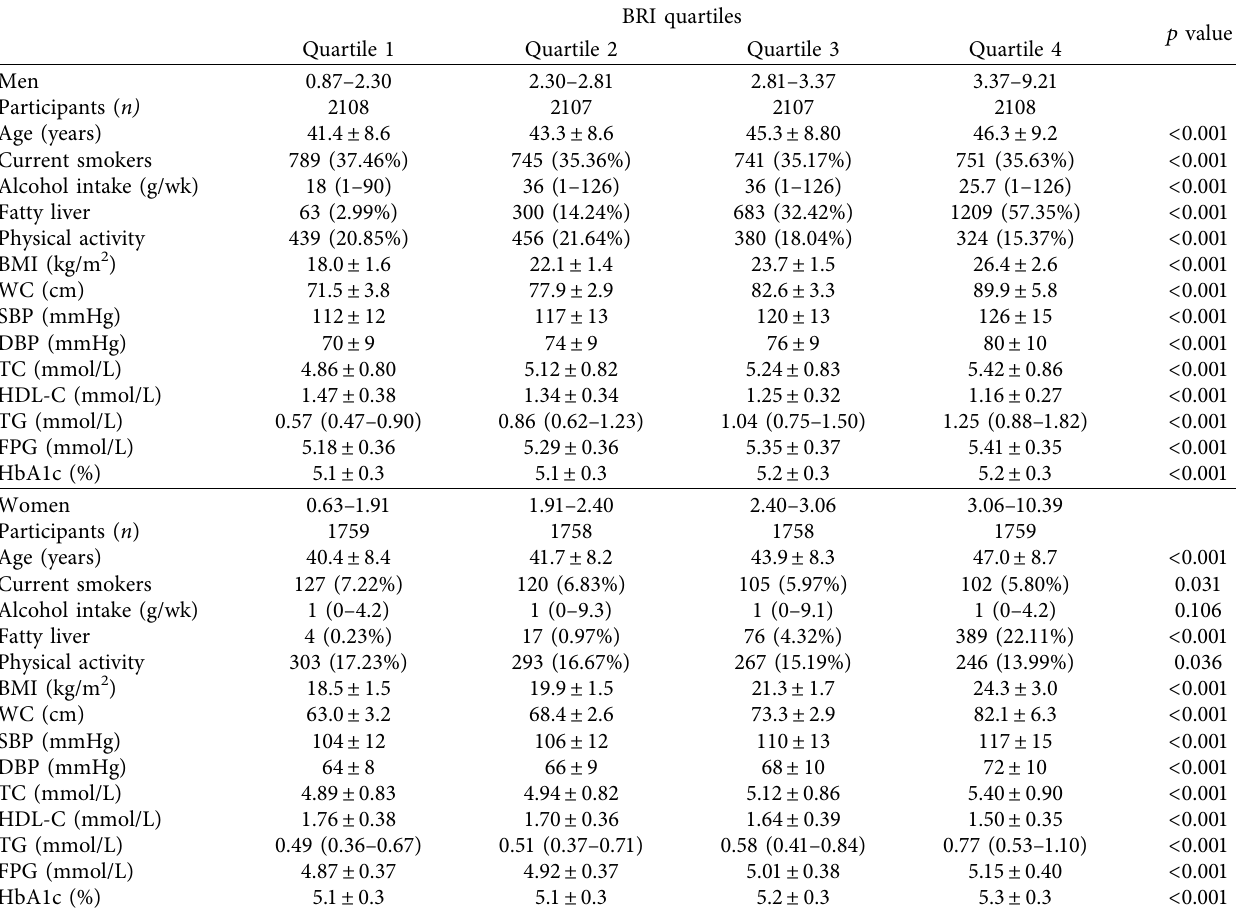
Table 1: Baseline characteristics of participants in men and women by categories of BRI in the NAGALA